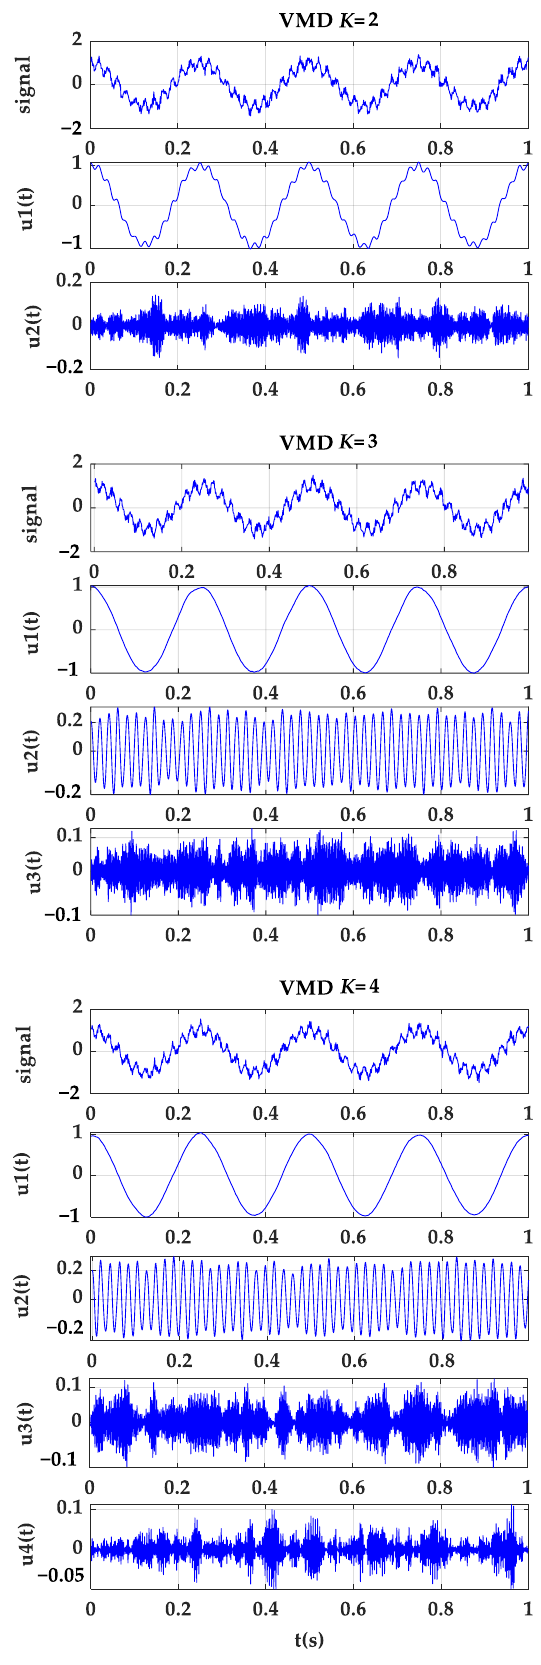
Figure 2. 𝐾 = 2, 3,4 VMD exploded view. Figure 2. K = 2, 3, 4 VMD exploded